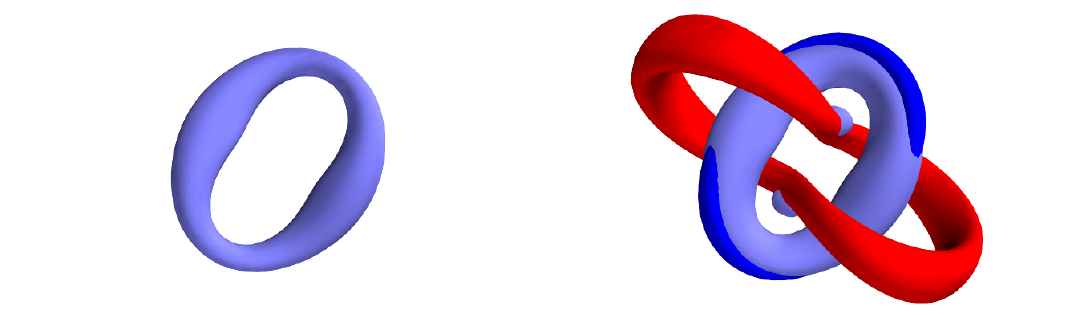
Figure 6 . Isosurfaces showing the energy density of the Q = 2 Hop(cid:12)on in the Faddeev-Skyrme (cid:0) (cid:1) 2 model (2.4) with the potential V = m 2 (cid:30) 1 (cid:0) 1 at c 2 = 0 : 5 ; c 4 = 1 ; m = 4 and E = 100 (left plot). 3 The energy isosurfaces at E = 90 together with the location curves (cid:30) 1 = (cid:6) 0 : 9 (right plot). values of the energy density the corresponding tube is not decomposed into four isolated beads, as it happens in the model with Heisenberg type potential